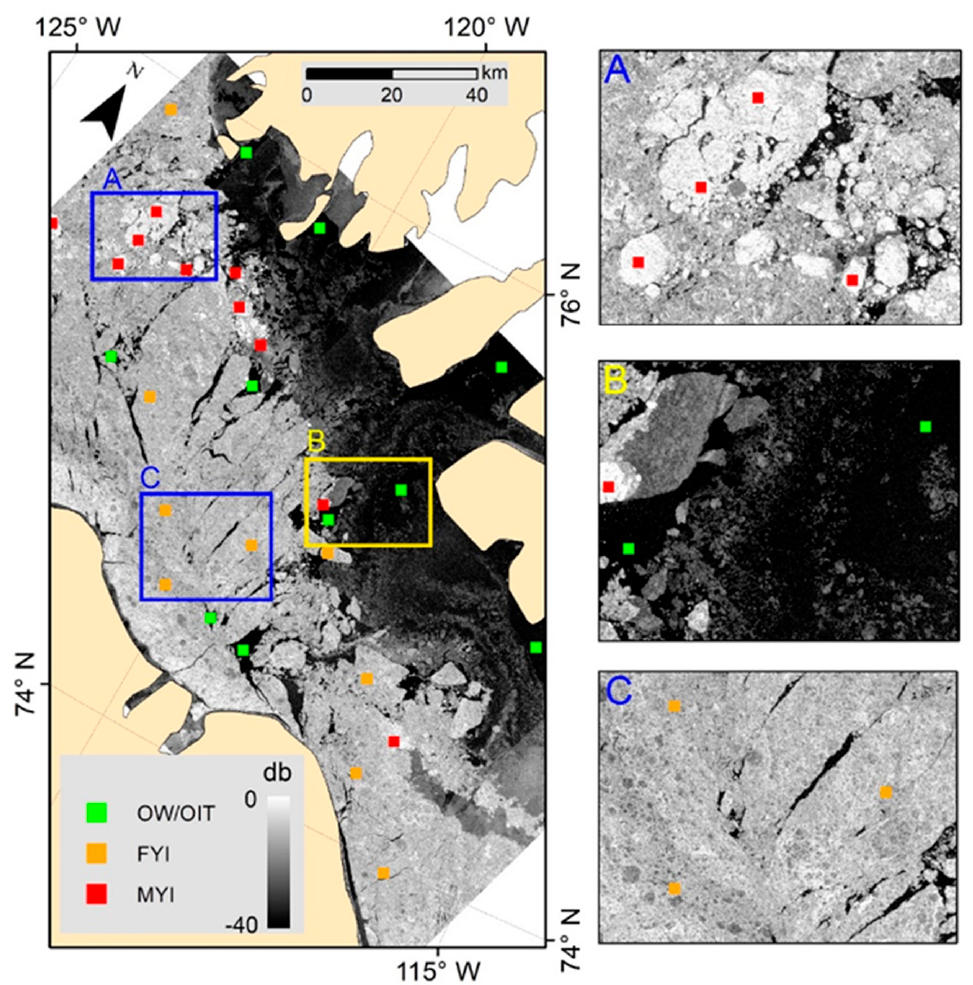
Figure 4. The selected samples of the three ice types in Sentinel-1B σ o image acquired on 22 September 2018. The sub-images show some samples for each type ( A is for MYI, B is for OW / OIT, C is for FYI).